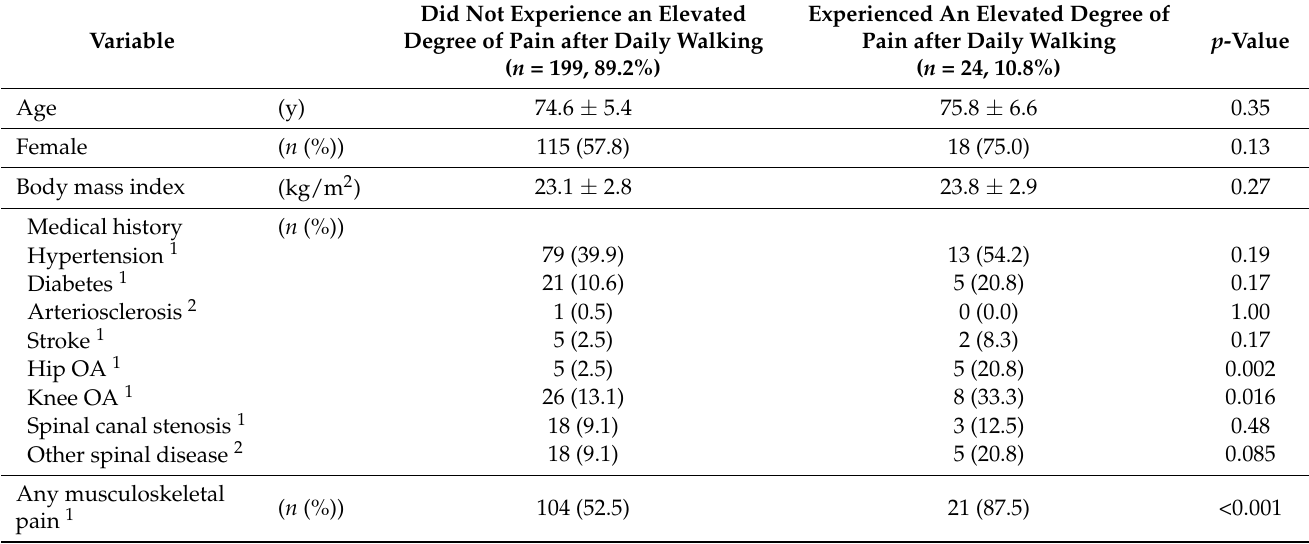
Table 1. Characteristics of subjects based on the experience of an elevated degree of pain after daily